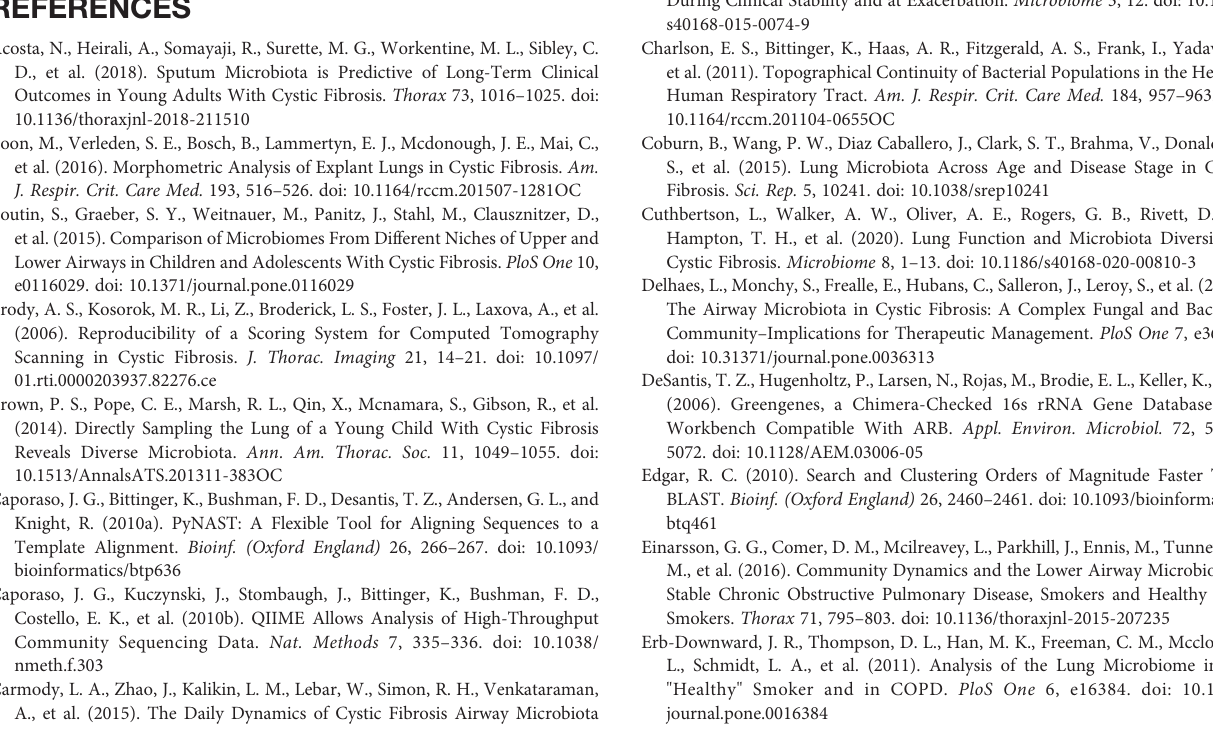
Supplementary Figure 1 | Main features observed by micro-CT imaging in CF and control donor lungs. Supplementary Figure 2 | Comparison between the mean relative abundance of the top 10 genera in the 20 matched CF tissue and luminal mucus samples. P <0.05 denotes statistical signi fi cance. Supplementary Figure 3 | Relative abundance (RA) ofallgenera present >1%for all samples belonging to each individual patient. Sample names are denoted as: Px.x, patient/lung-slice number (from apex to base); (Px.x.) S/L, small or large airway; (Px.x.S/L.) S/T, luminal mucus or tissue. Supplementary Figure 4 | Difference in the compositional variance between individual lungs calculated using the “ betadisper ” function from the vegan package (2.4-6) in R, followed by signi fi cance testing using a permutation test. The permutation test assesses signi fi cant differences of median distance to centroid. P <0.05 denotes statistical signi fi cance with 999 permutations. Supplementary Figure 5 | Comparison of ecological parameters in lung slices ranging from slice 2 (apex) to slice 11 (base) of the lungs (A) Shannon-Wiener diversity (B) dominance. Supplementary Figure 6 | Comparison of ecological parameters (Shannon- Wiener diversity and dominance) in samples in which features of end-stage lung disease were present or absent on micro-CT images (A) fi brosis (B) emphysema and (C) obliterations. P <0.05 denotes statistical signi fi